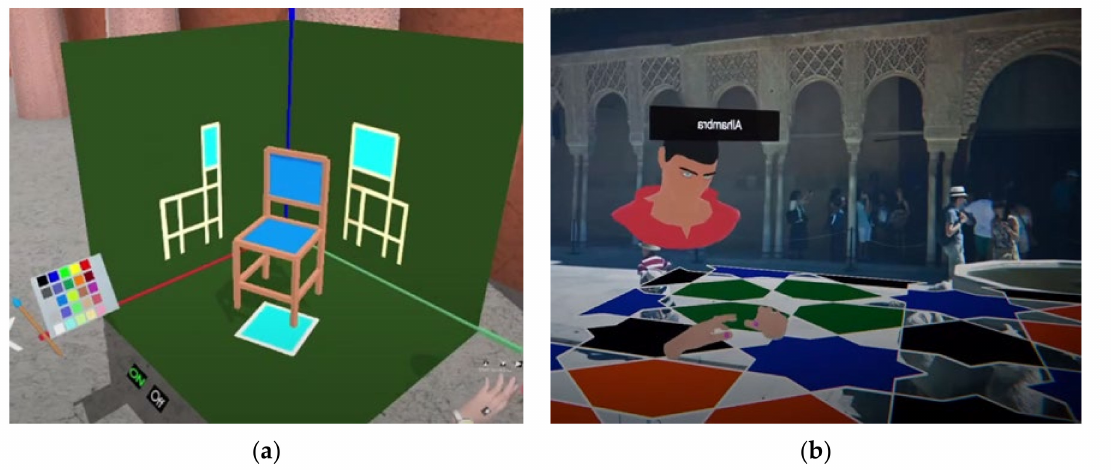
Figure 6. ( a ) Modeling a chair. ( b ) Personalized scene of the Courtyard of the Lions of the